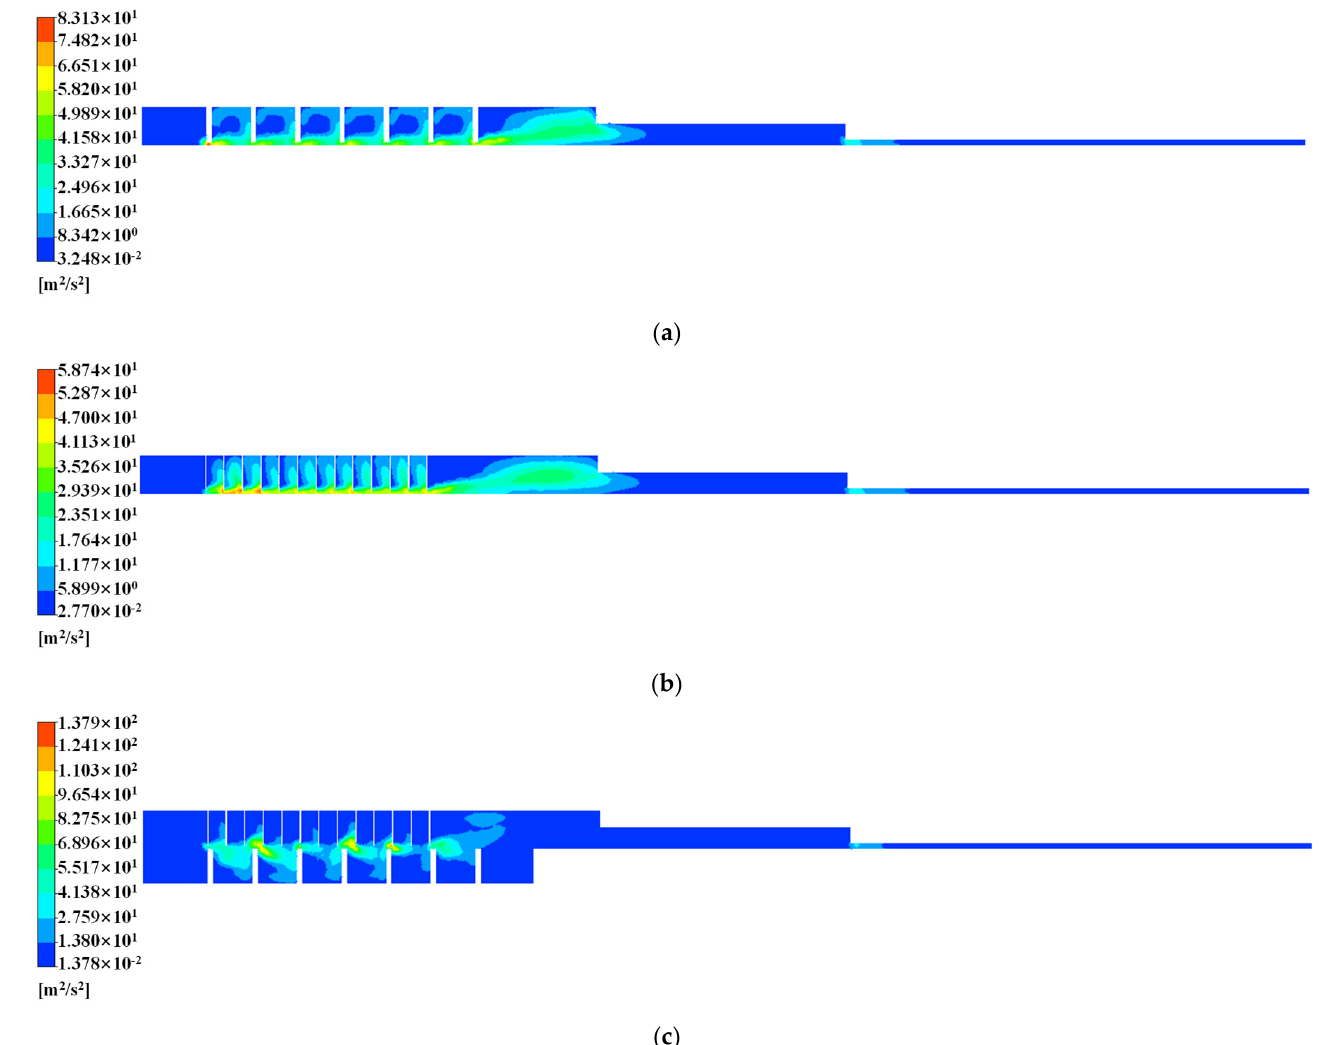
Figure 6. Turbulent kinetic energy diagram of three types of seals (RE = 0 mm). ( a ) Labyrinth seal; ( b ) honeycomb seal; ( c ) hybrid labyrinth–honeycomb seal.